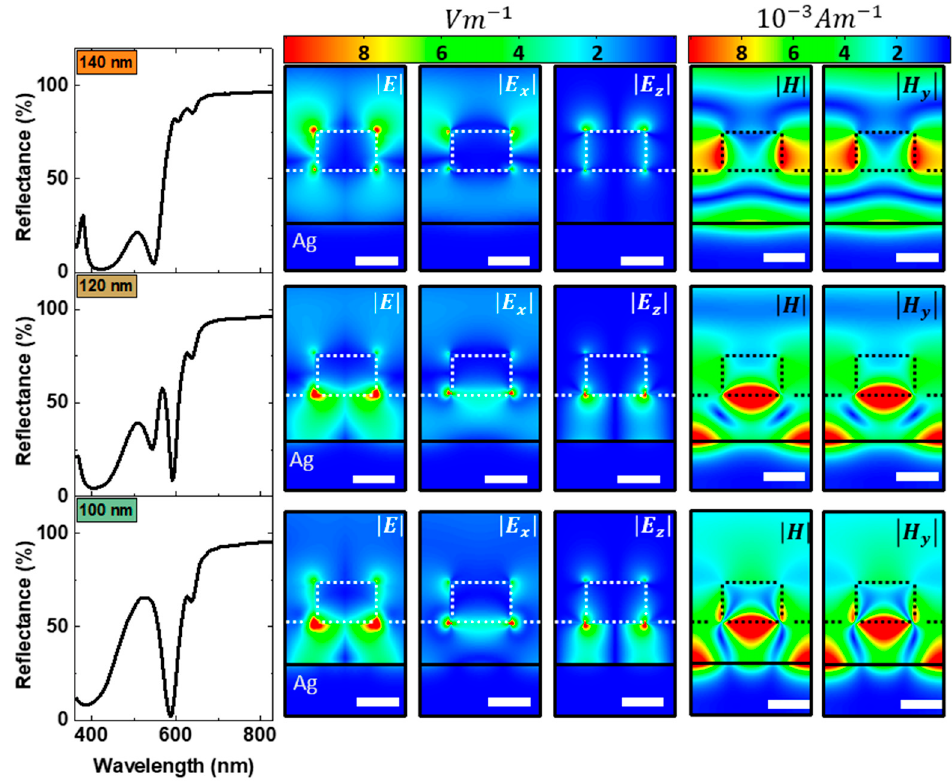
Figure 3. Electric and magnetic field distributions at 585 nm along the vertical cross section (x–z plane) through one unit cell of hybrid structures with polymer thicknesses of 140 nm, 120 nm and 100 nm. In our coordinate system, the plane wave excitation is normally incident from the air side of the nanostructure, i.e., k vector parallel to the z–axis, and p–polarized, polarization parallel to the x-axis. The black line in the field maps indicates the polymer silver interface. The white scale bar is 100 nm.